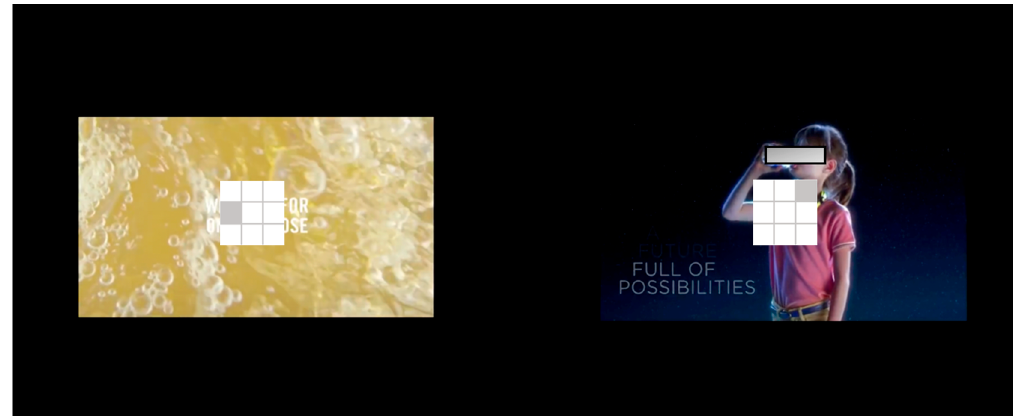
Figure 1. An example figure of the experimental stimuli used in the dual-probe task, with a beer advert on the left, and a water advert on the right side of the example. The left probe stimulus corresponds to a “4” response on the number pad. The right probe stimulus corresponds to a “9” response on the number pad.